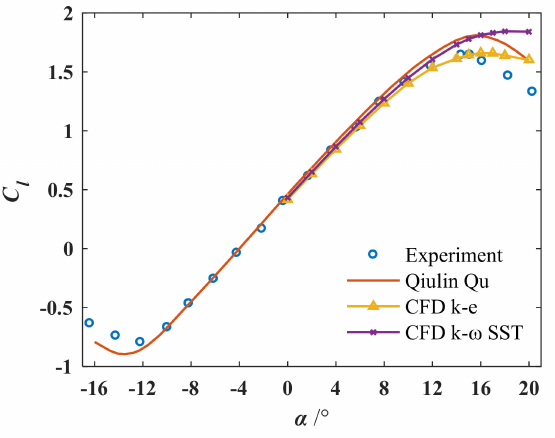
Figure 5. Lift coe ffi cient curve for